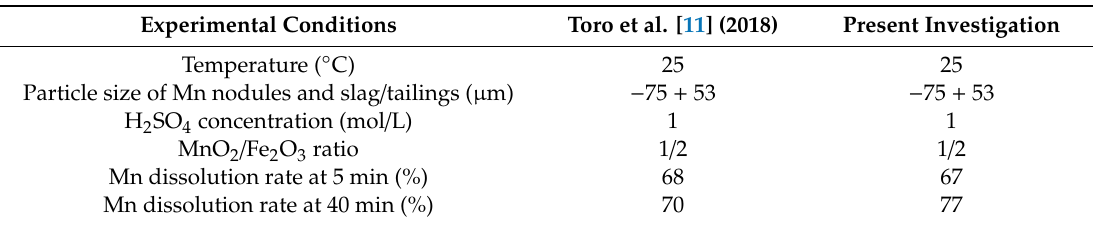
Table 6. Comparison of the experimental